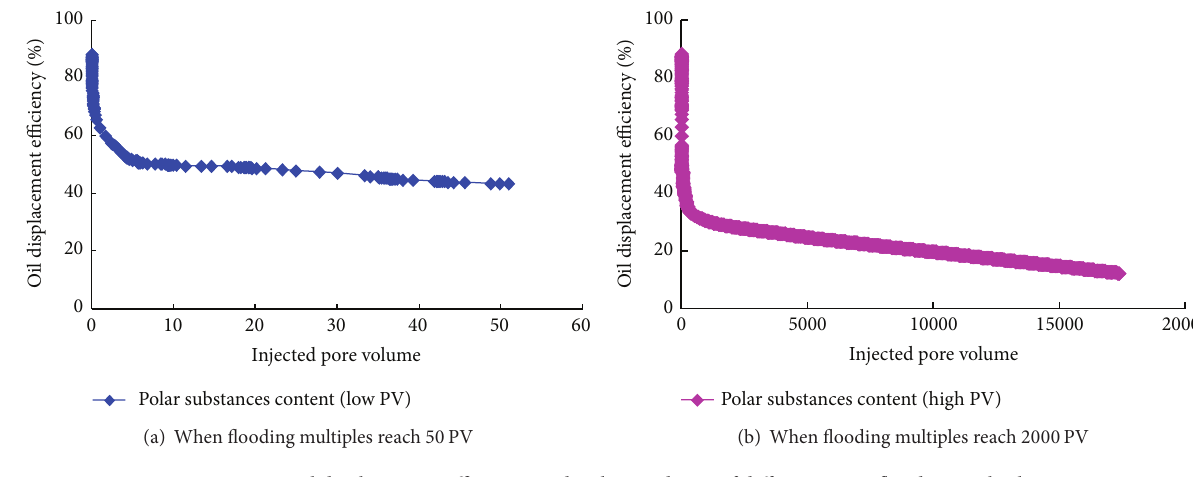
Figure 11: Oil displacement efficiency under the condition of different water flooding multiples.